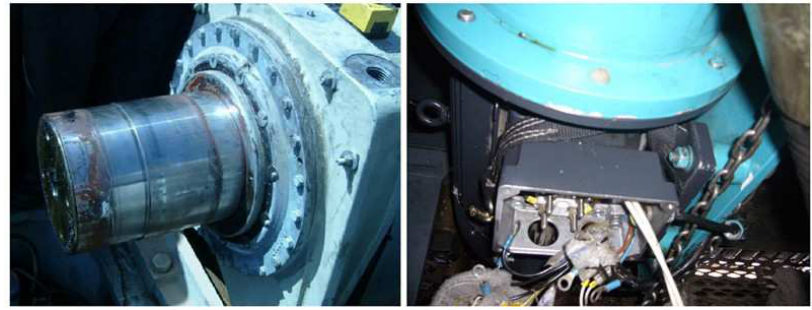
Figure 8. Fault gearbox bearing and test picture.